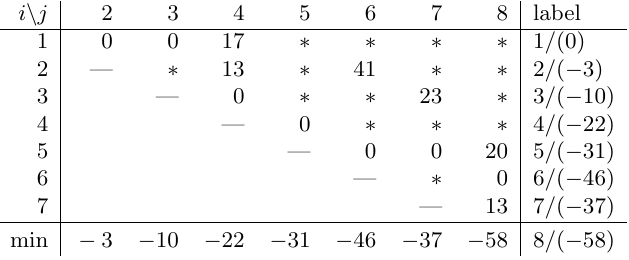
Table 2: Modified activity weights after the minimum incoming weight label algorithm has been applied to the CPM network in Figure